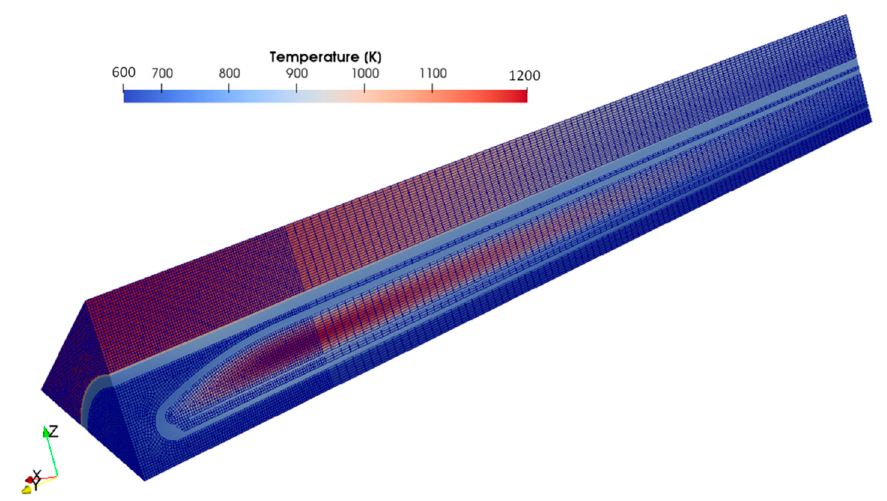
Figure 2. 3D temperature field in a 60° sector of a DEMO HCPB fuel pin [1].